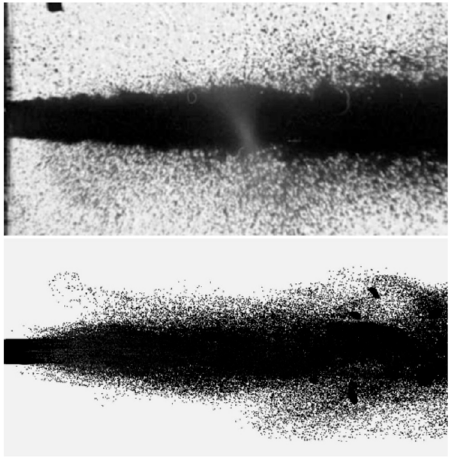
Figure 14. Comparison of experimental shadowgraph [61,63] and numerical simulation result [61]. Reproduced with permission from Elsevier.